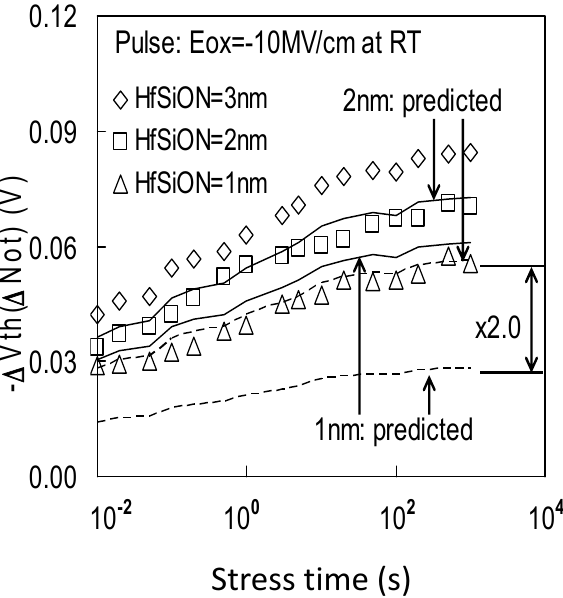
Figure 5. NBTI-induced positive charges with different HfSiON thicknesses. Symbols are test data. The dashed lines are predictions made by assuming charges at the Hf-k/SiON interface, which did not agree with test data. The solid lines are predictions made by assuming charges at SiON/Si interface, which agreed well with test data [43].